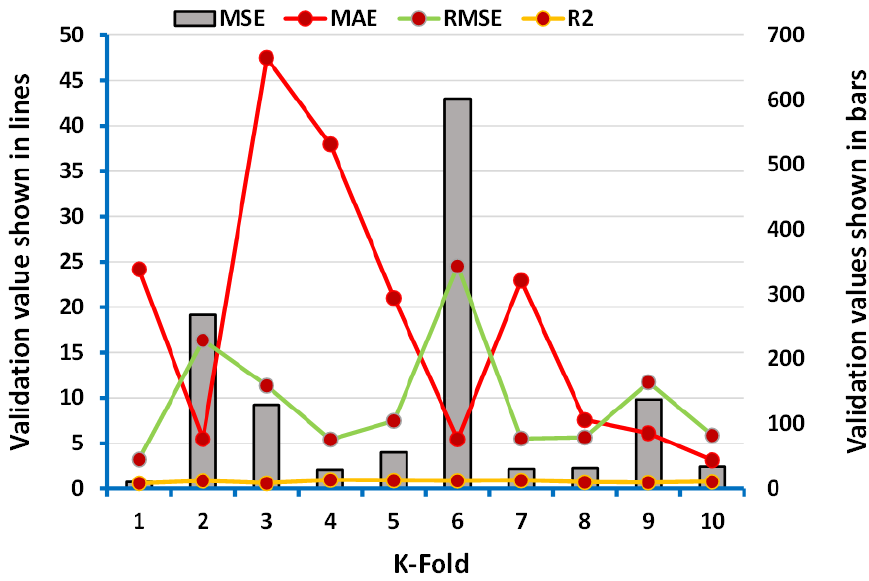
Figure 9 Representation of the statistics for k-fold cross-validation of the boosting model.